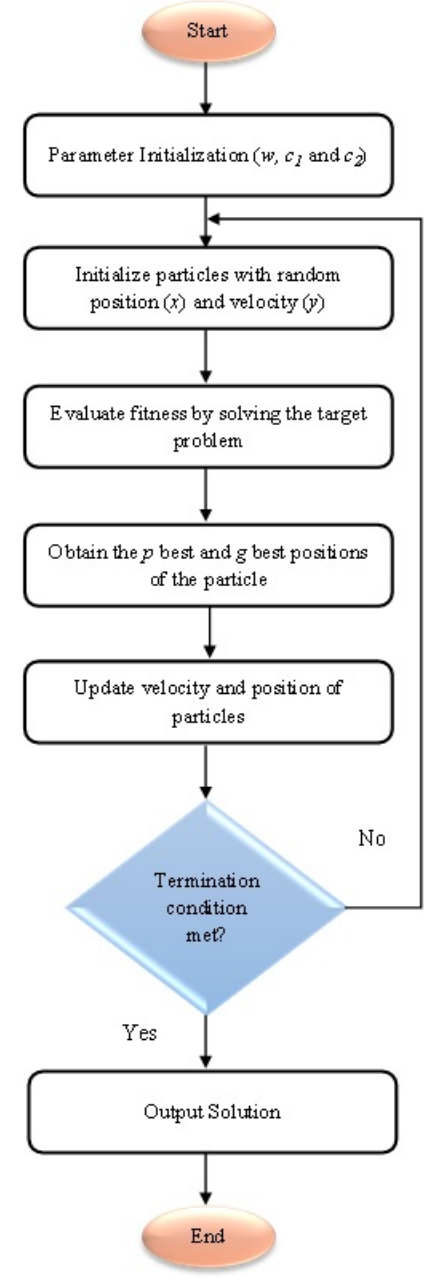
Figure 5. PSO algorithm flow chart [39].